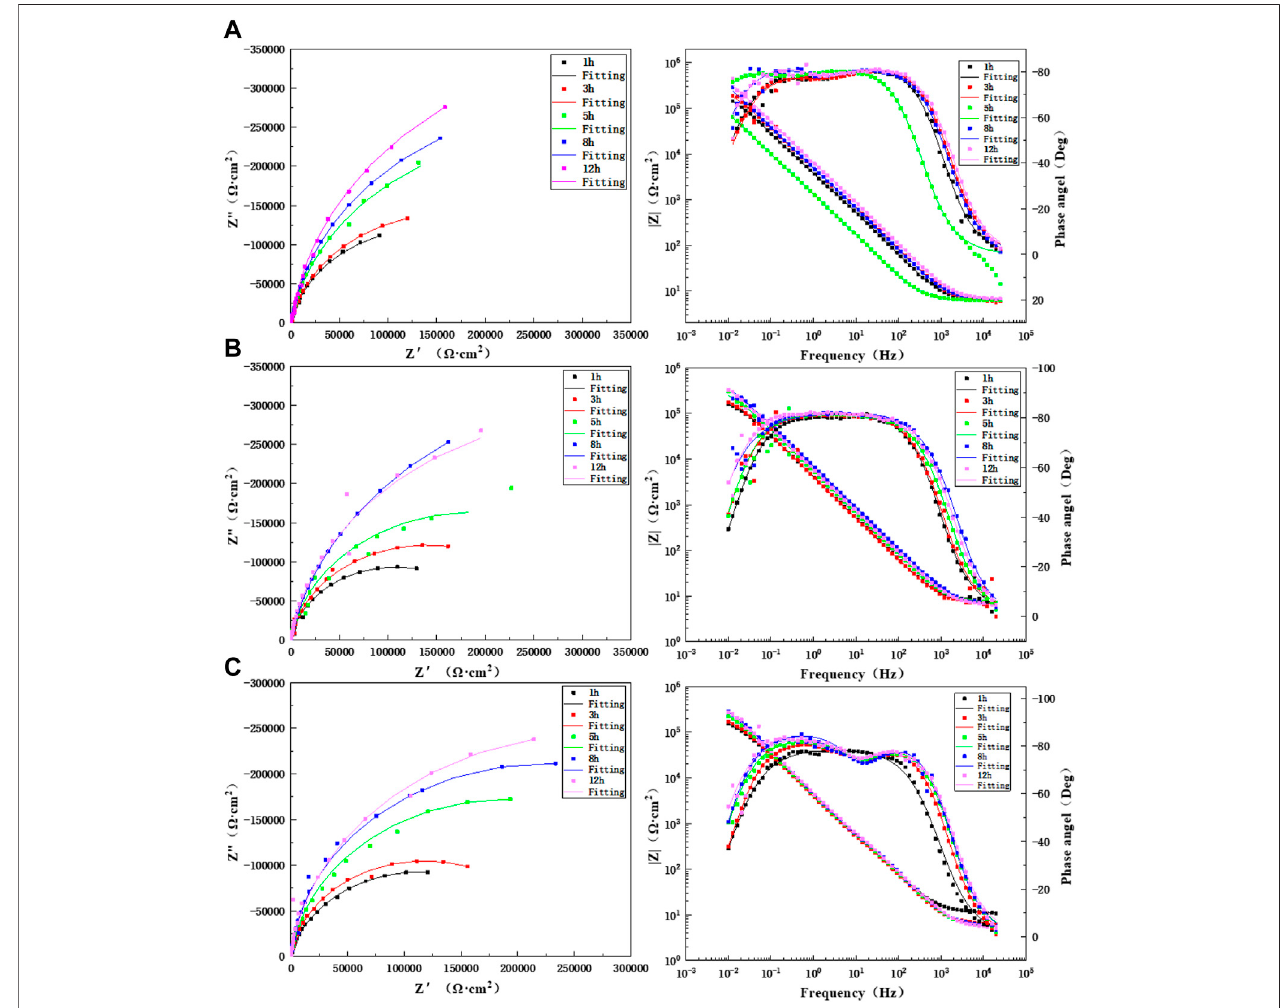
FIGURE 6 | Impedance changes of BM during 12 h of scouring in arti fi cial seawater: (A) 1.85 m/s, (B) 3 m/s, and (C) 6 m/s.